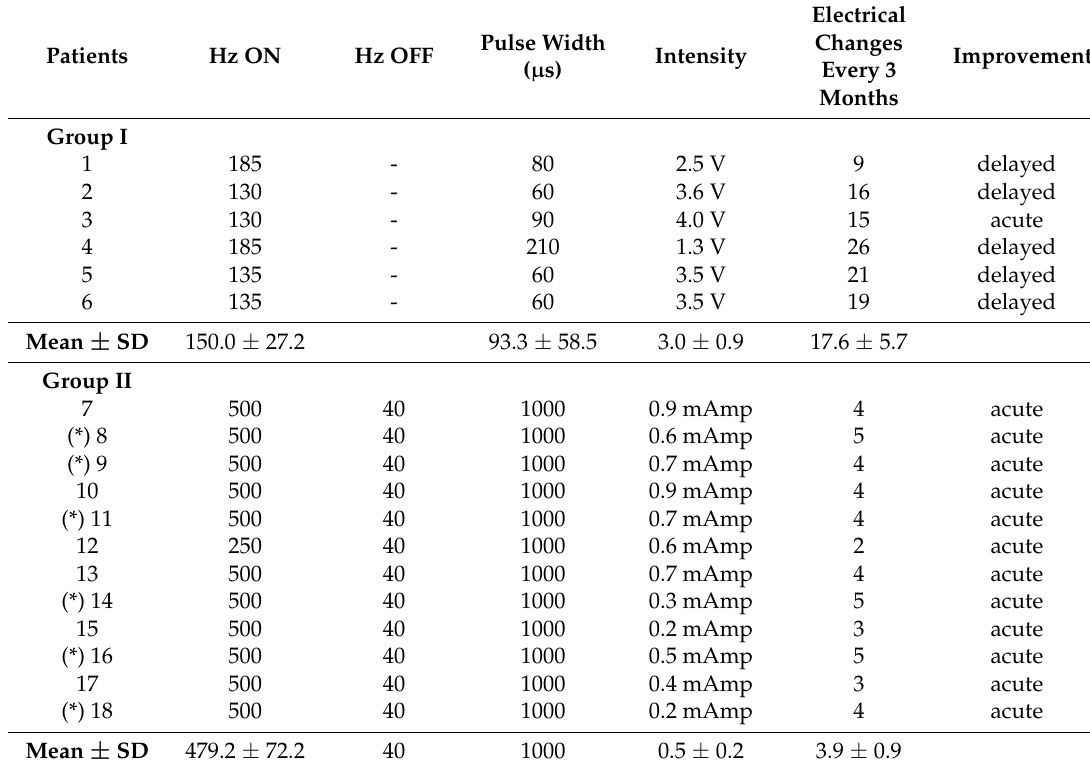
Table 2. Stimulation